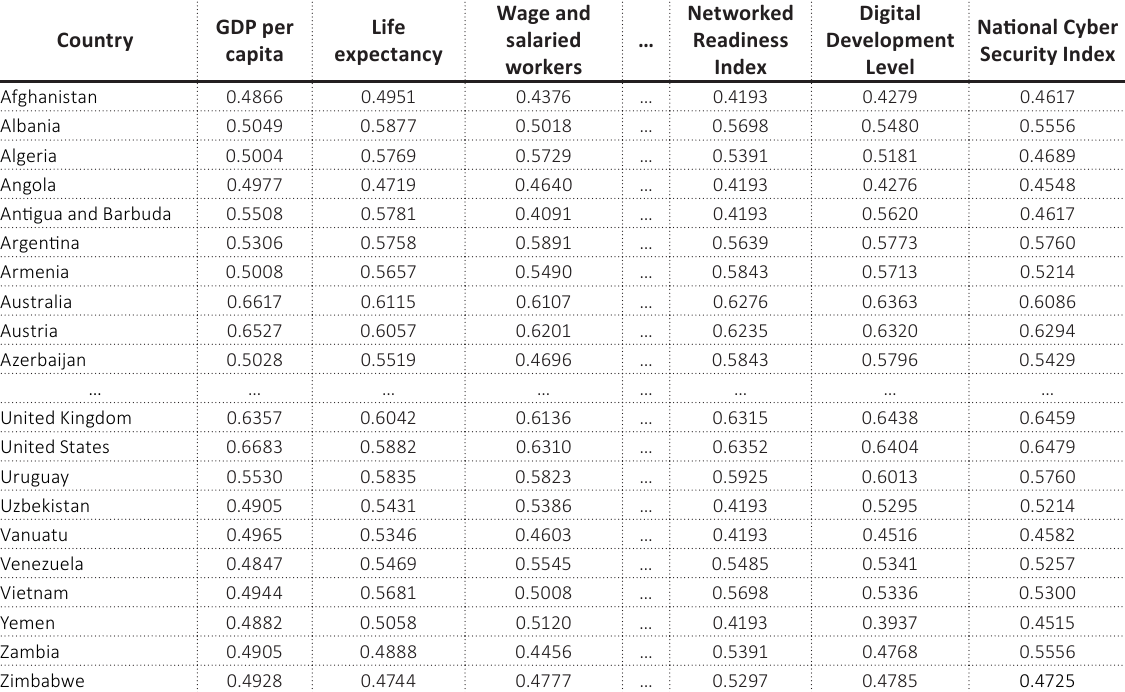
Table 4. The values of components of the information security threat index reduced to the dimensionless Harrington desirability scale